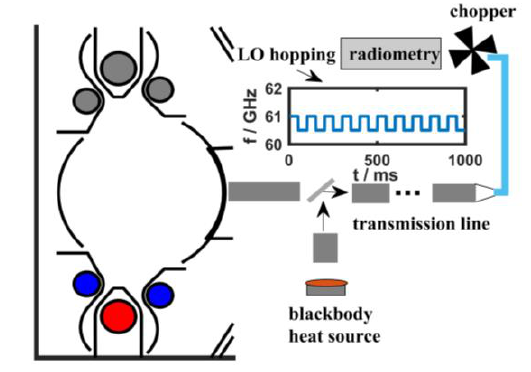
Fig. 1. Schematic diagram of obtaining the relative variation ratio of the calibration coefficients in the two hopping LO frequencies.